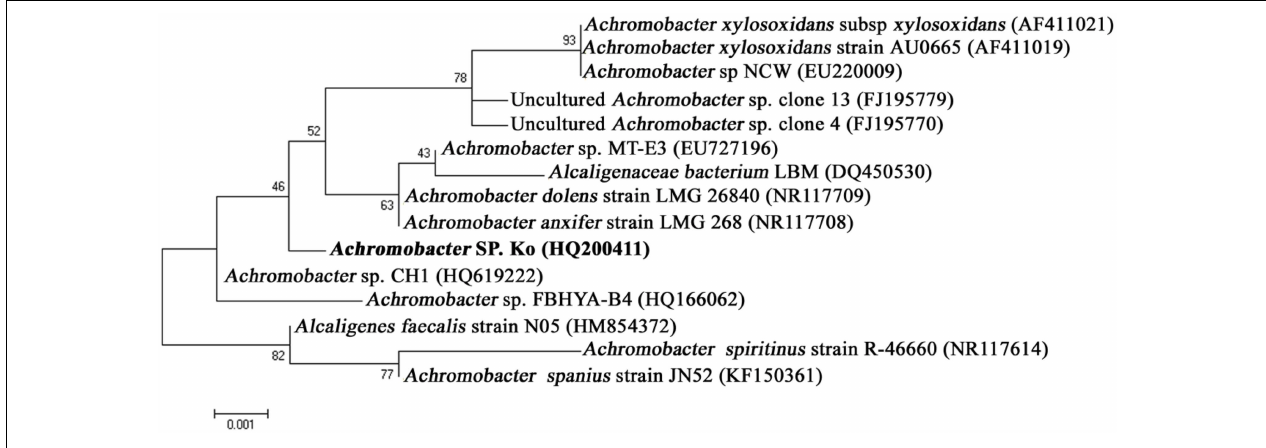
FIGURE 1 | Phylogenic relationships of Achromobacter sp. strain isolated from Rhabditis (Oscheius) sp. and known bacterial relatives based on 16S rDNA gene sequences (neighbor-joining method).